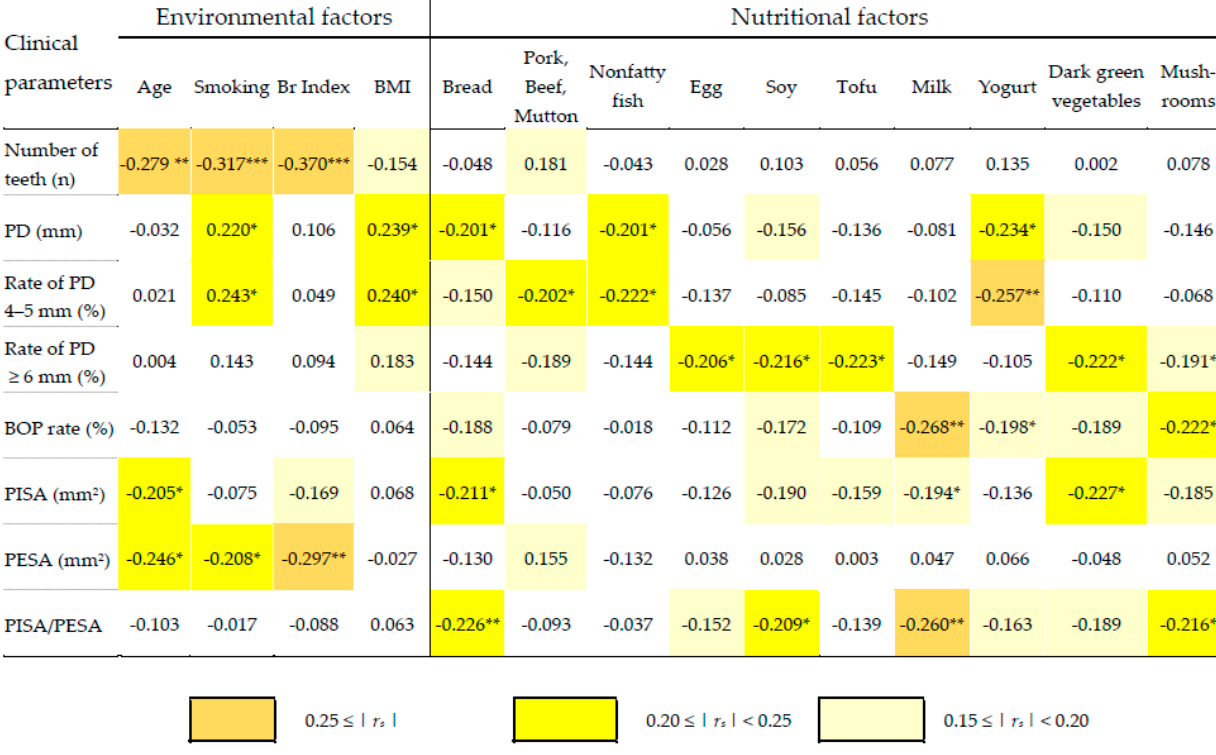
Figure 1. Correlation coefficient matrix. Spearman’s rank correlation coefficient ( r s ) between eight periodontal parameters, four environmental factors, and ten nutritional factors at SPT2. Boxes in the matrix are painted by color in response to correlation coefficient as shown above. Student’s t-distribution was used for comparisons of differences in correlation coefficients (* p < 0.05, ** p < 0.01, *** p < 0.001). Abbreviations: BMI, body mass index; Br index, Brinkman index; PD, probing depth; BOP, bleeding on probing; PISA, periodontal inflamed surface area; PESA, periodontal epithelial surface area.